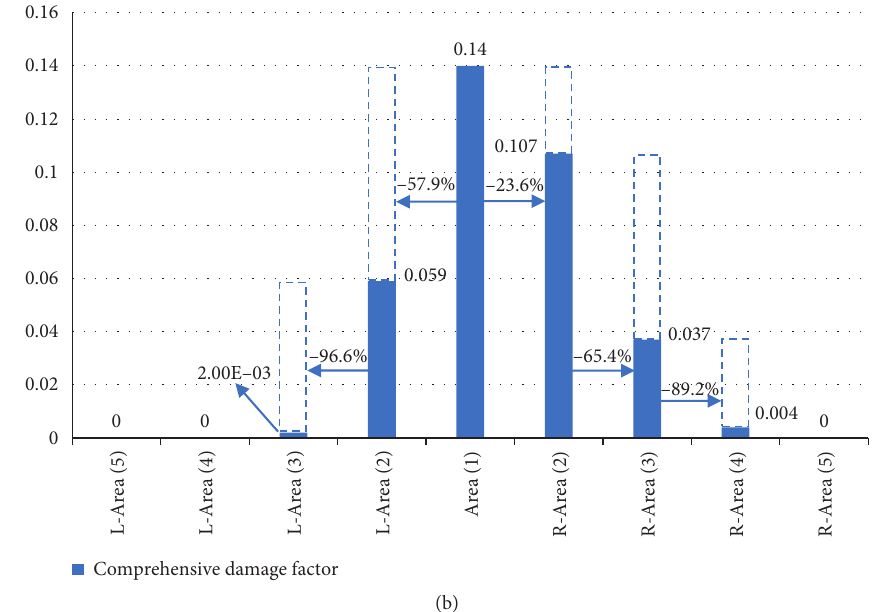
Figure 12: Comparison of average comprehensive damage factors in the radial direction: (a) SFRC and (b) ordinary